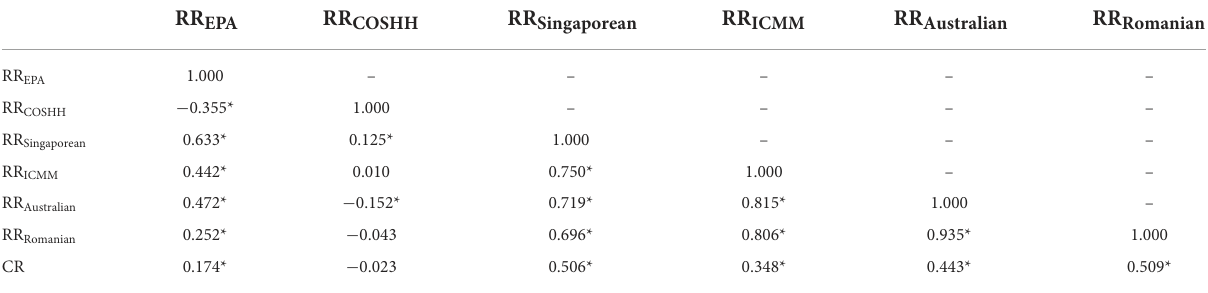
TABLE 5 Correlations among the RR values of the six OHRA